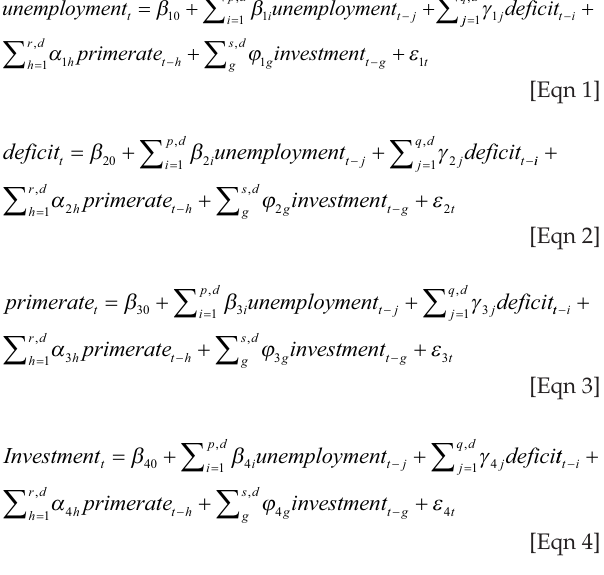
In equation (5), p, q, r and s are optimal lag lengths determined by information criteria. The error term, ε , is assumed to be t identically and independently distributed with a mean of zero and a constant variance. After performing an F-bounds test for cointegration on [Eqn 5], and establishing the existence of a cointegrating relationship, an ARDL error correction representation can be estimated. The ARDL